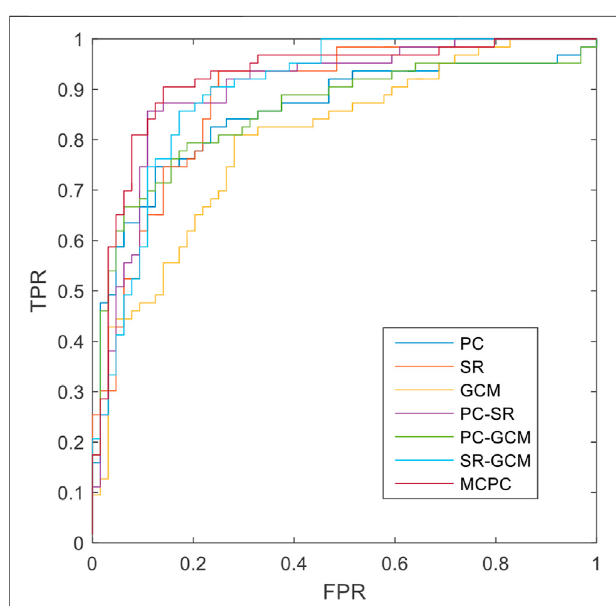
FIGURE 4 | The ROCs of different